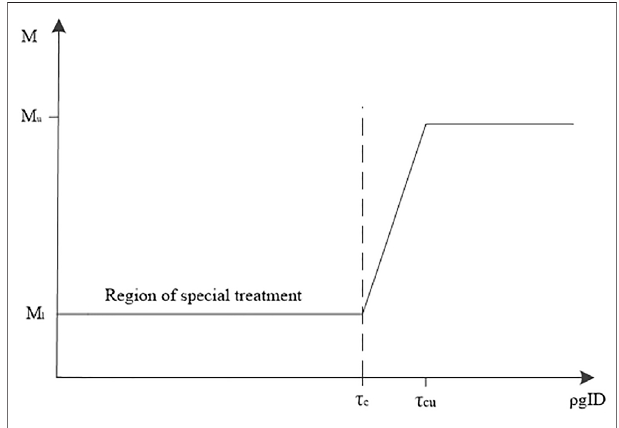
FIGURE 6 | Relationship between shear force and the Manning coef fi cient.